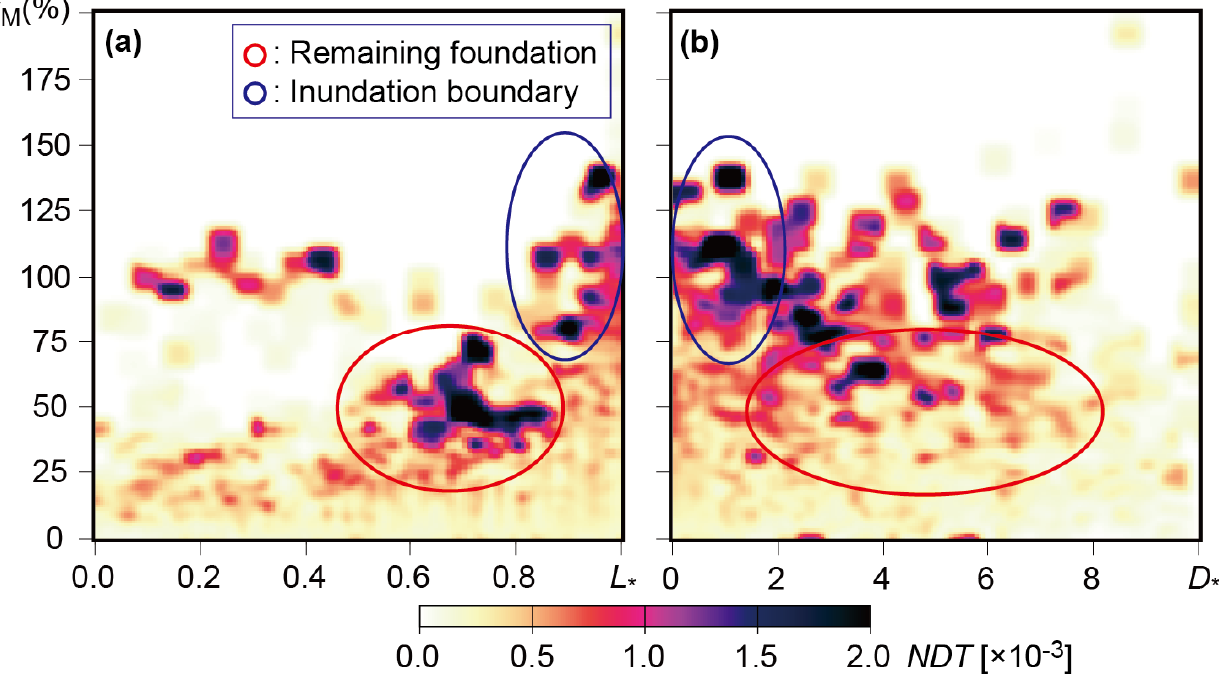
Figure 7. ( a ) Relationships among i M , L *, and NDT . ( b ) Relationships among i M , D *, and NDT . Each figure from Imai et al. [6].